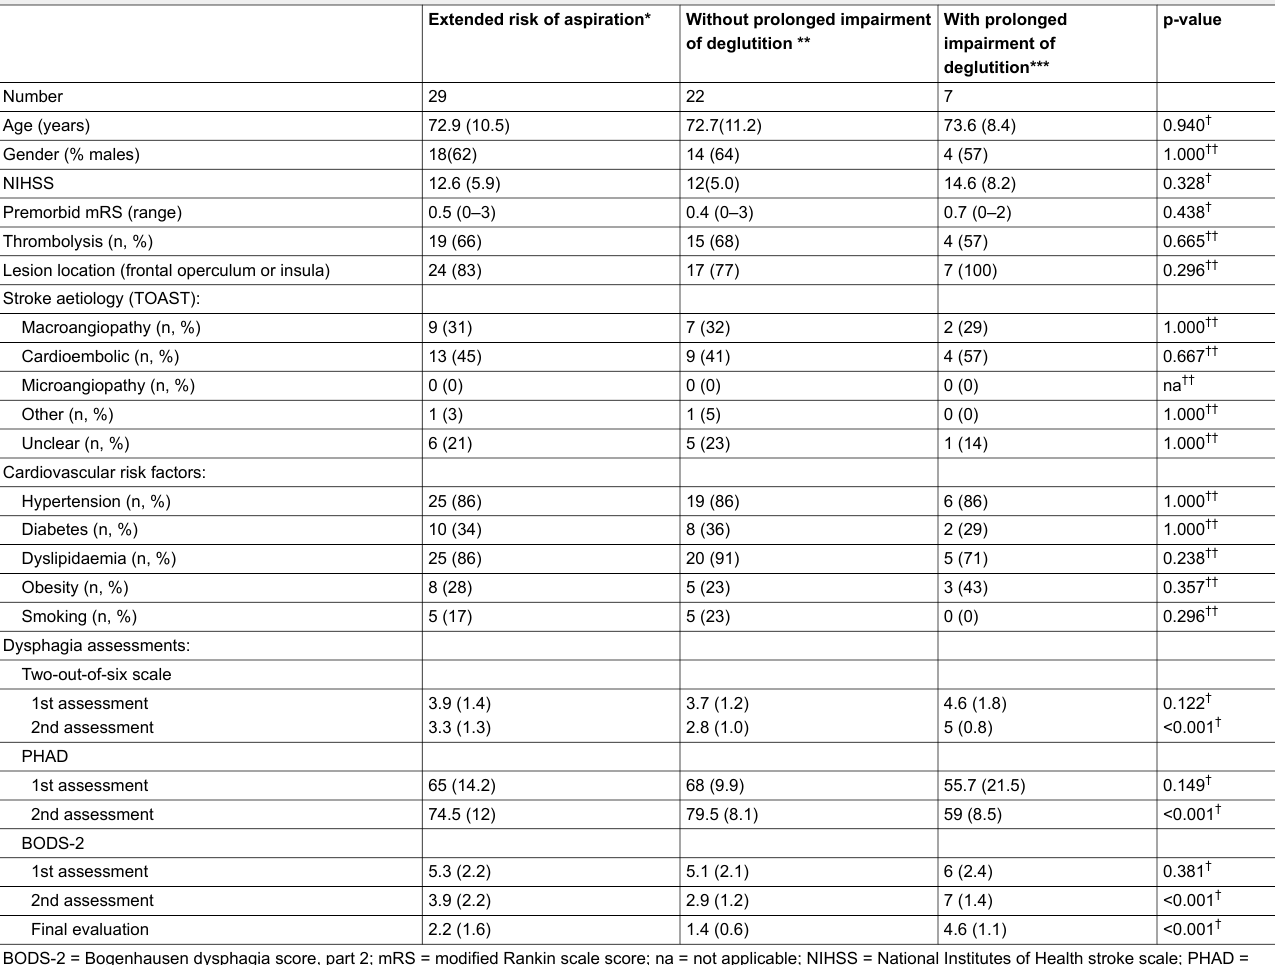
Table 1: Descriptive statistics of patients with extended risk of aspiration with or without prolonged impairment of deglutition.